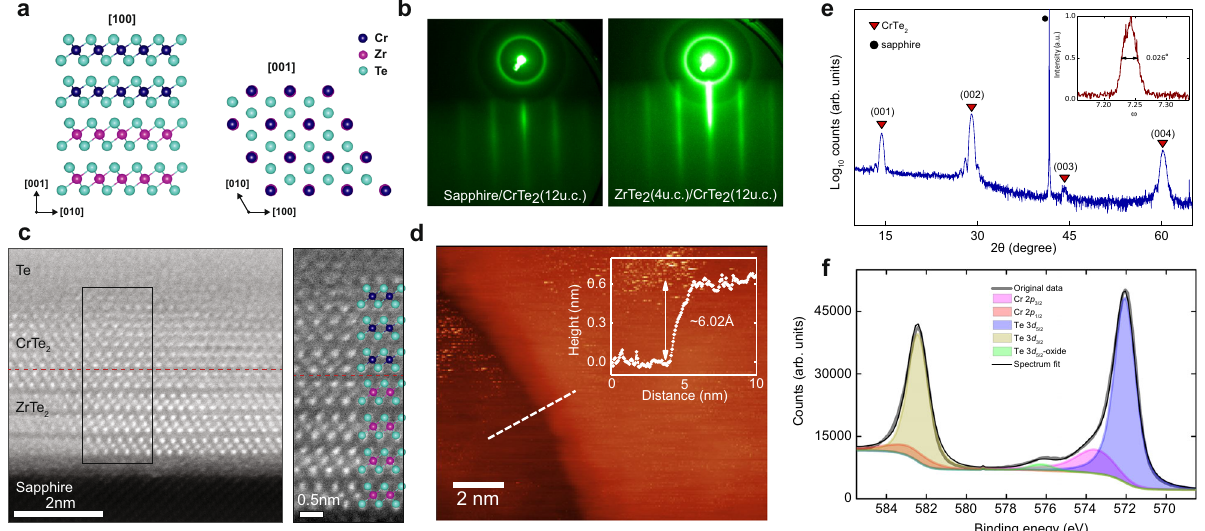
Fig. 1 MBE and characterization of 1T-CrTe 2 thin fi lms. a Schematics of the 1 T phase of CrTe 2 grown on ZrTe 2 . Note that [100], [010], and [001] (cid:1) (cid:3) (cid:1) (cid:3) correspond to (cid:1) 12 (cid:1) 10 , 2 (cid:1) 1 (cid:1) 10 , and [0001] in the 4 axis Miller – Bravais notation. b RHEED patterns of the single layer of CrTe 2 (12 u.c.) and ZrTe 2 (4 u.c.)/ CrTe 2 (12 u.c.) heterostructure. The substrate is sapphire in both cases and the electron beam is directed along the [11 (cid:1) 20] orientation of sapphire. c HAADF-STEM images of the ZrTe 2 (4 u.c.)/CrTe 2 (3 u.c.) heterostructure viewed in cross-section. The images have been low-pass fi ltered for clarity. d STM image of a ZrTe 2 (4 u.c.)/CrTe 2 (1 u.c.) sample. The line scan shows the thickness of the 1 u.c. CrTe 2 . e XRD 2 θ scan of a 12 u.c. CrTe 2 thin fi lm. f XPS spectrum of an 18 u.c. thick CrTe 2 fi lm. The small Te oxide shoulder is due to the absence of a capping layer in this sample. The counts in e and f are in arbitrary units